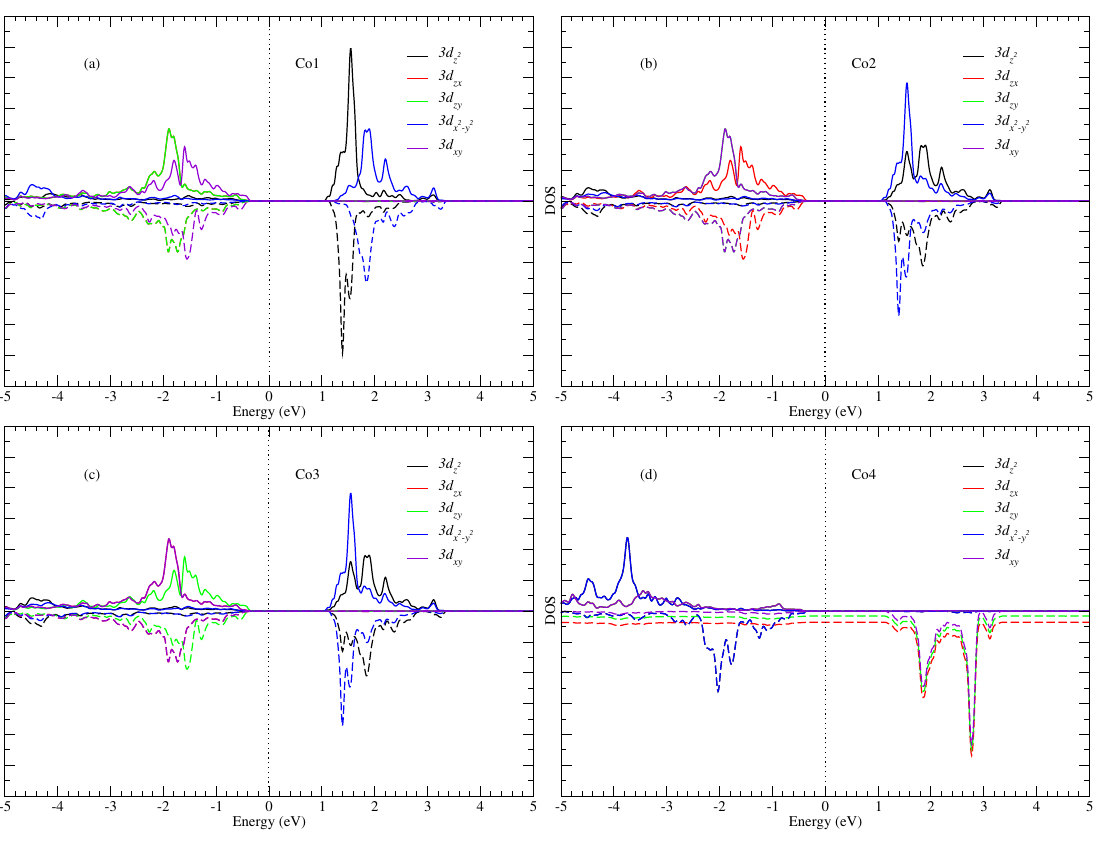
e 0 g , i.e., containing 2g , 2g